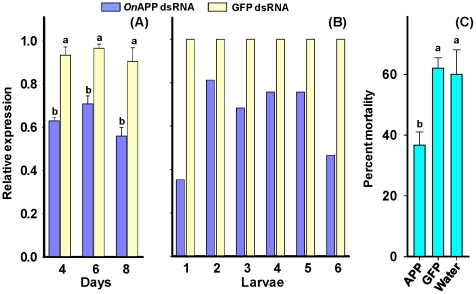
The expression of OnAPP gene in the larvae fed OnAPP dsRNA and GFP dsRNA.Immediately after the larvae developed into second instar, they were individually fed fresh artificial ECB diet containing dsRNA. (A) The expression of OnAPP gene in OnAPP dsRNA and GFP dsRNA treated larvae after 4, 6, and 8 days. Standard errors of the means were determined from three biological replications, each with two technical replications. (B) The expression of OnAPP for six individual midguts after 8 days of dsRNA feeding. (C) Percent mortality in OnAPP dsRNA, GFP dsRNA , and water treated larvae. Standard errors of the means were determined from three replications; each replication consisted of 50 larvae. Different letters represent significant difference with p value ≤0.05.